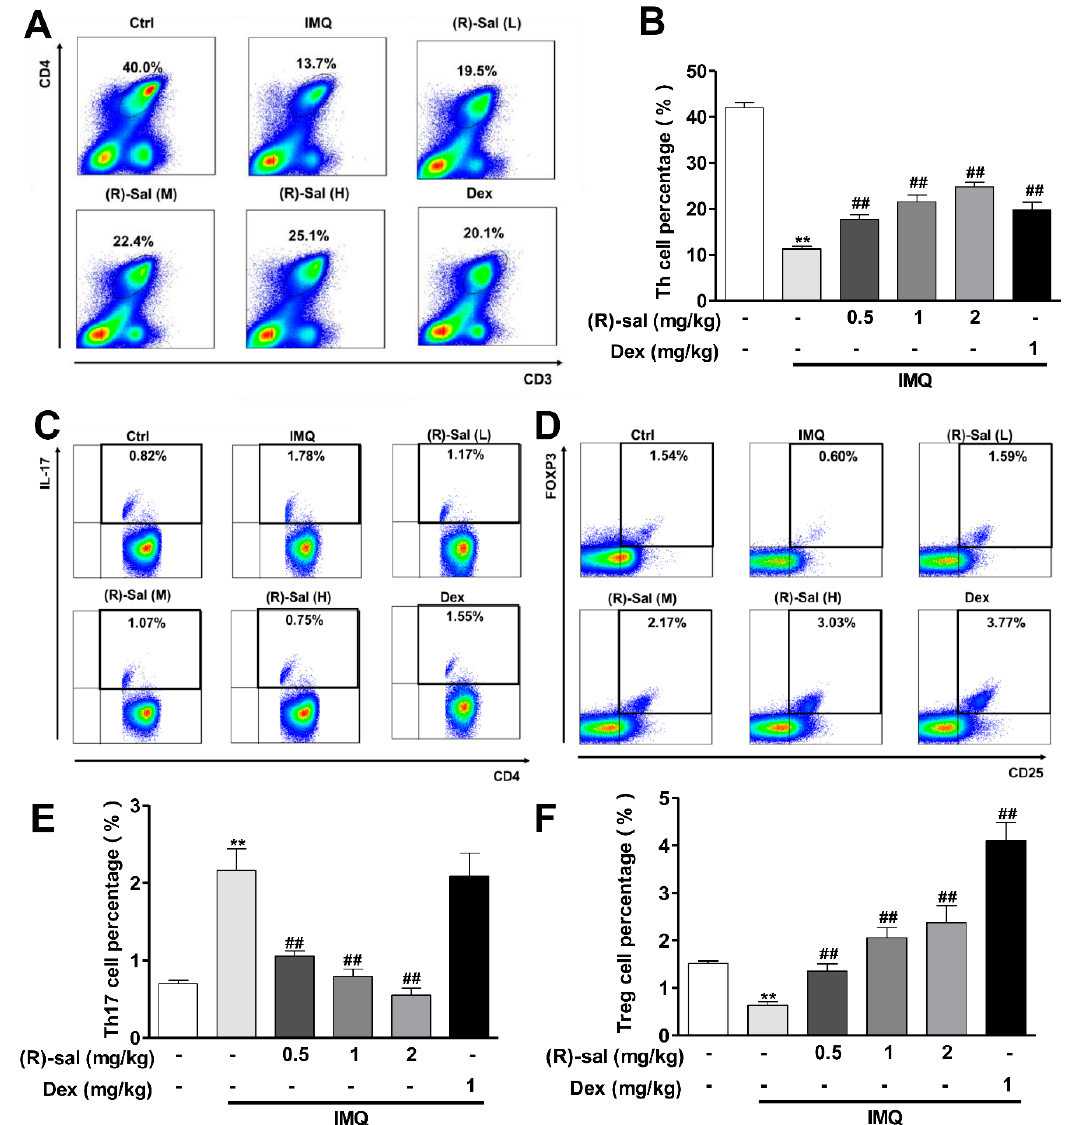
Figure 6. The influence of ( R )-salbutamol on Th17 cells and Treg cells levels. Spleen cells were obtained from mice on day 8 and then stimulated with cocktail (with Brefeldin) for 6 h. Thereafter, they were stained with fluorescent conjugated anti-mouse CD3, CD25, and CD4. In addition, intracellular staining of IL-17 and Foxp3 was performed using the respective antibodies. Representative contour plots showed the frequency of live CD4+ T cells, IL-17+ Th17 gated and CD25+ Foxp3+ Treg in the splenocytes isolated from mice treated with IMQ and then with ( R )-salbutamol. Relative scatter plots showed the frequencies determined from live cells. ( A ) Representative dot plots showing the percentage of CD3+CD4+ T cells. ( B ) Statistical analysis of the percentage of CD3+CD4+ T cells. ( C ) Expression of intracellular cytokines IL-17 was detected by flow cytometry in cells gated for CD4+. ( D ) FoxP3 stained with a Foxp3 staining buffer set without stimulation, with CD25+ surface as the gate. ( E , F ) Statistical analysis of the above results. ## p < 0.01, relative to IMQ group. ** p < 0.01, relative to the control group. Error bars represent the mean ± SD ( n = 8).